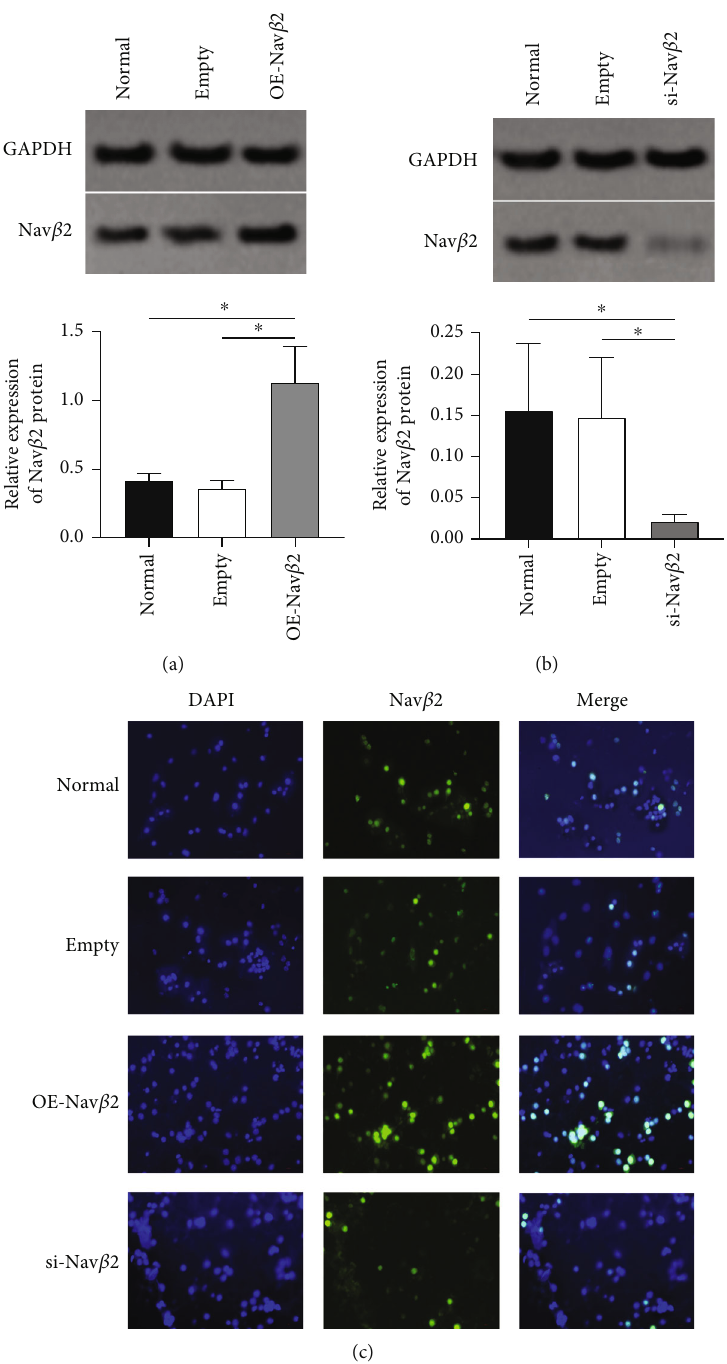
Figure 2: Changes in Nav β 2 protein levels of neuronal cells after lentivirus transfection (scale bar: 200 μ m). (a) Quantitative and Western blot images of Nav β 2 protein expression after transfection of neurons with overexpressed Nav β 2 lentivirus vector ( n = 3 ). ∗ Versus two di ff erent treatment groups, P < 0 : 05 . (b) Quantitative and Western blot images of Nav β 2 protein expression after transfection of neurons with interfering Nav β 2 lentivirus vector ( n = 3 ). ∗ Versus two di ff erent treatment groups, P < 0 : 05 . (c) Immuno fl uorescence staining of Nav β 2 after transfection of neurons with overexpressed or interfering Nav β 2 lentivirus vector. Normal group: normal cultured neurons without treatment; empty group: the neurons which introduced the empty viral